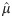
Differences in the HMM parameter estimates between subjects with schizophrenia and control subjects.(A) μ^ during continuous presentation and p^SS and φ^S for intermittent presentation (B). Each grey dot indicates one individual participant’s data, colored diamonds indicate medians, horizontal bars indicate 25%/75%-quantiles.